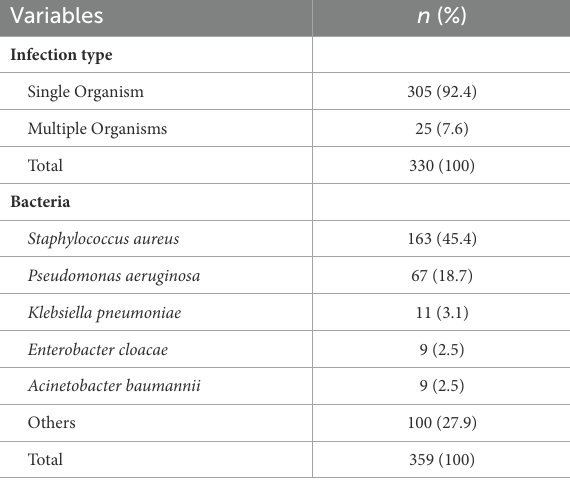
TABLE 2 Information on pathogenic